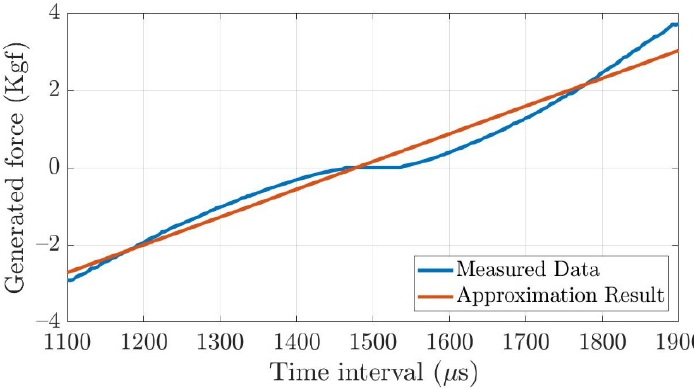
Figure 9. The generated force with respect to time interval (PWM) using linear approximation.